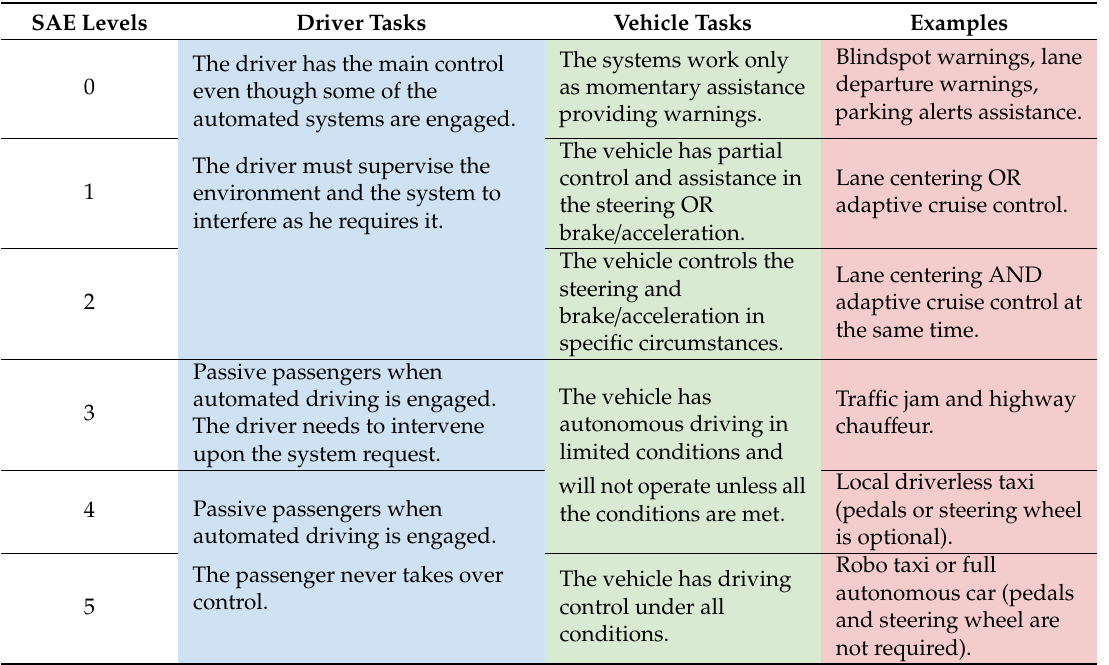
Table 1. Levels of driving automation based on the Society of Automotive Engineers (SAE) J3016 [6–8]. SAE